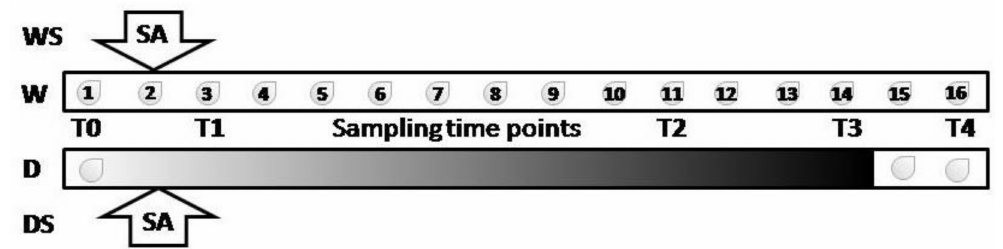
Figure 1. Experimental scheme. Droplets represent days of the experiment when the plants were watered. Drought stress severity is indicated by dark shading. Arrows indicate that salicylic acid (SA) was applied on the 2nd day of the experiment. T0 trough T4 are sampling times. Watered plants (W); drought-stressed plants (D); watered plants treated with SA (WS); drought-stressed plants treated with SA